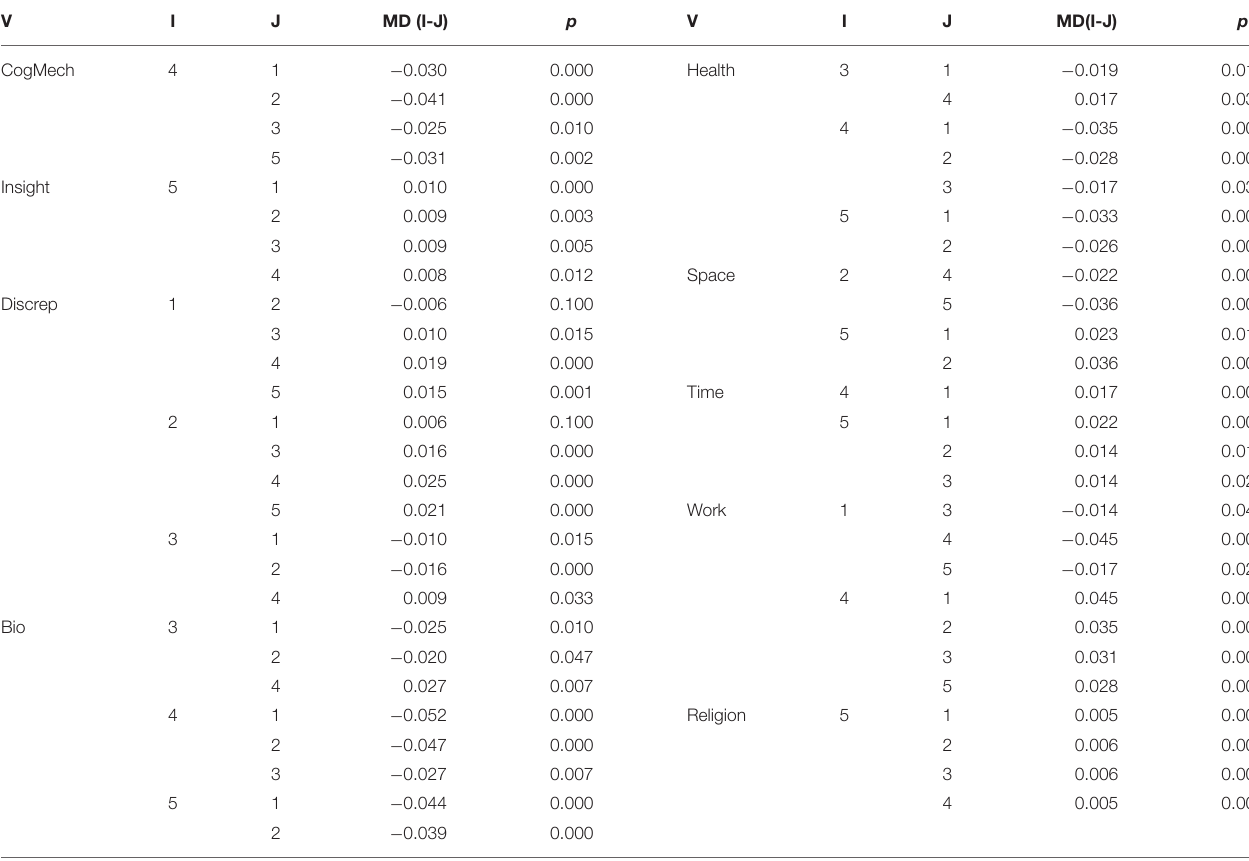
IandJrepresentthetwostagescompared,where1forInitialstage(Jan18–Feb5),2-Outbreakstage(Feb6–Feb21),3-Plateaustage(Feb22–Mar8),4-Recessionstage(Mar9-May7), 5-Regular Control stage (May 8–Oct 2). MD(I-J) is the mean-difference between I and J phases, where a positive value means the value of I stage is larger than J stage, and a negative value is the